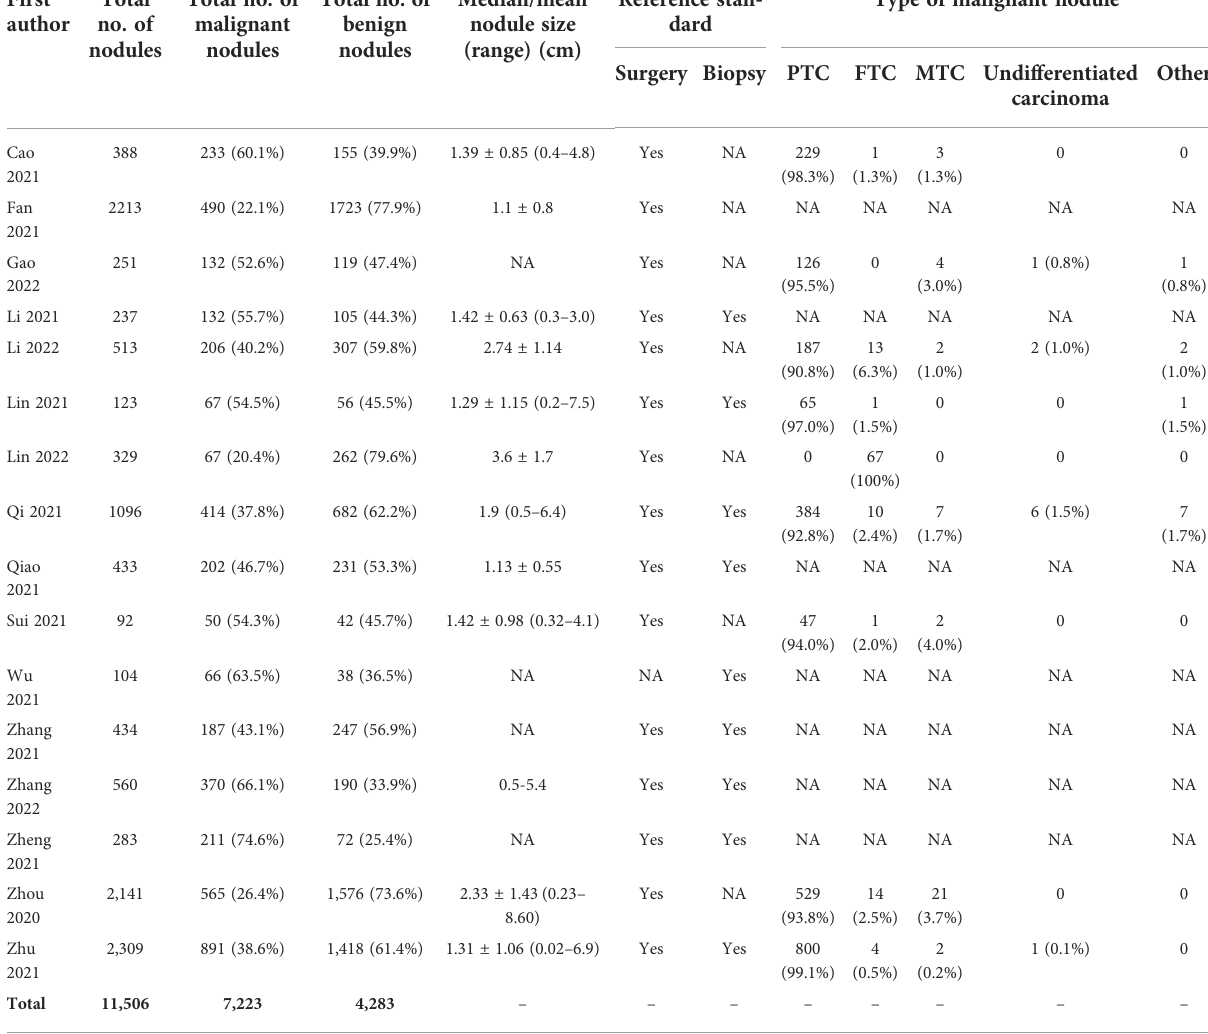
TABLE 3 Characteristics of thyroid nodules included.